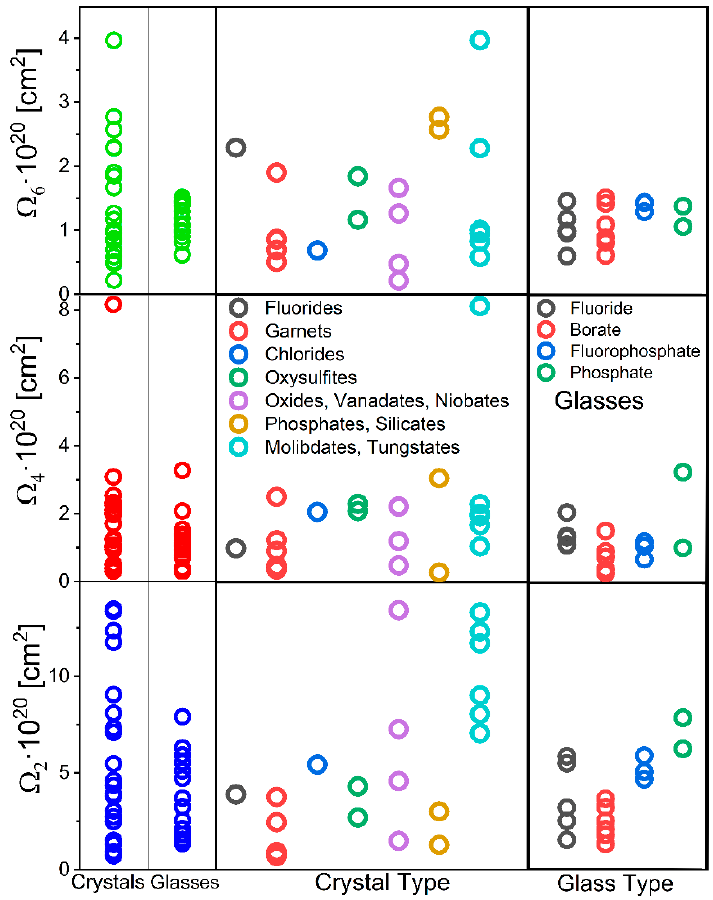
Figure 2. Slater integrals and s–o coupling parameters as listed in Table 2.